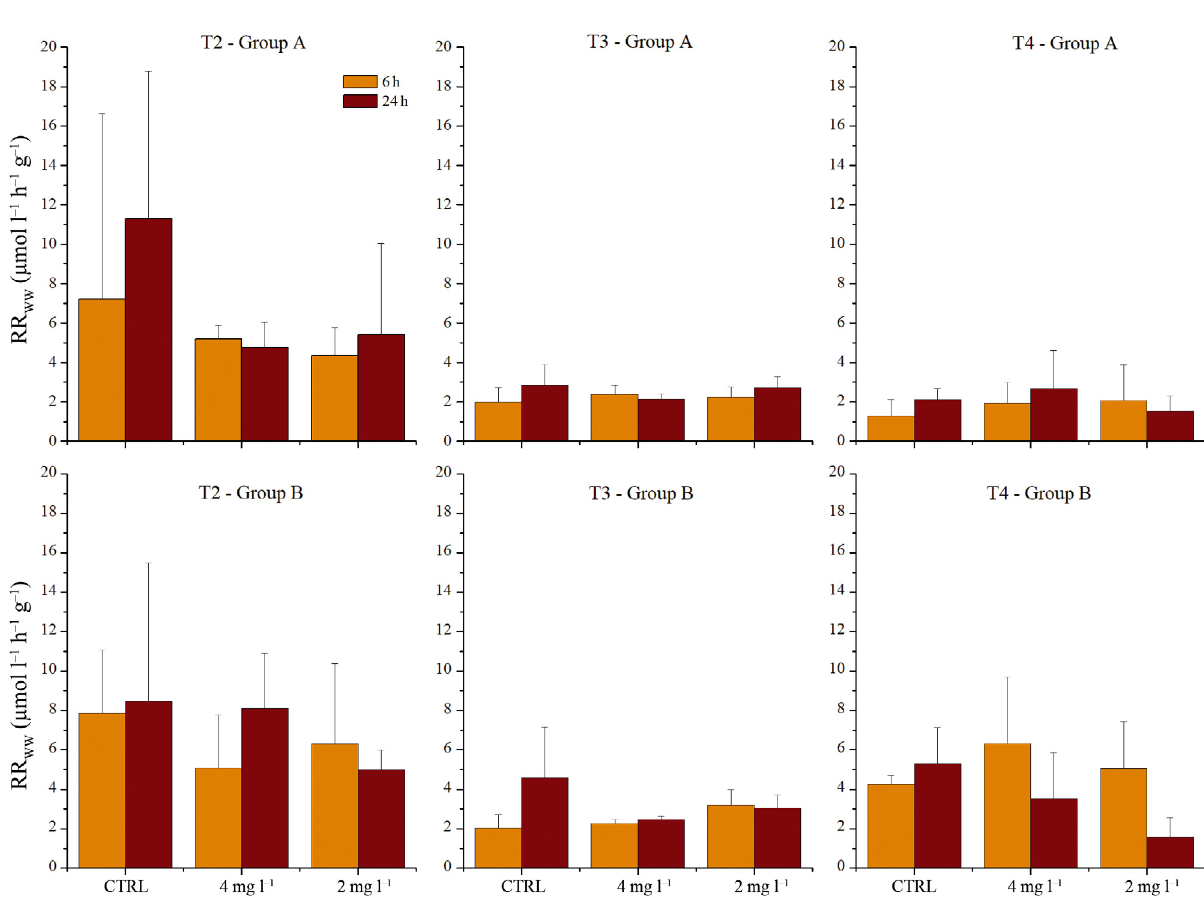
Fig. 2. Standardized respiration rates (RR) of biofouling communities at varying levels of oxygen availability. See Fig. 1 and Table 1 for further